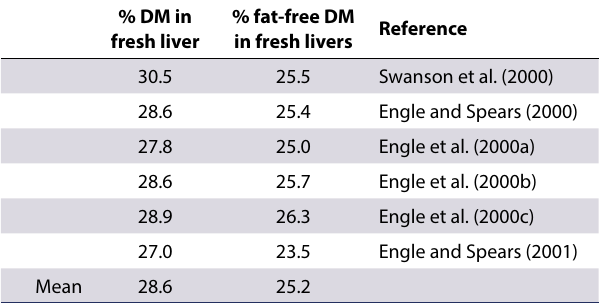
Table V: Effect of fat content on the dry matter (DM) content of cattle and sheep livers, calculated from published results % DM in fresh